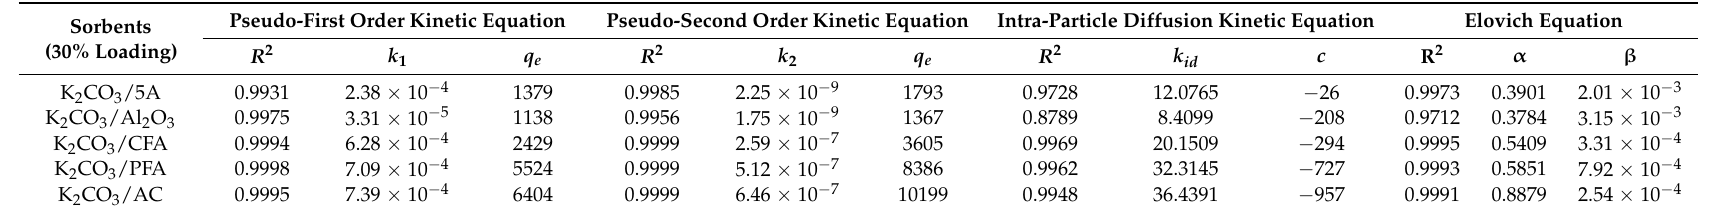
Table 4. Fitting parameters of different